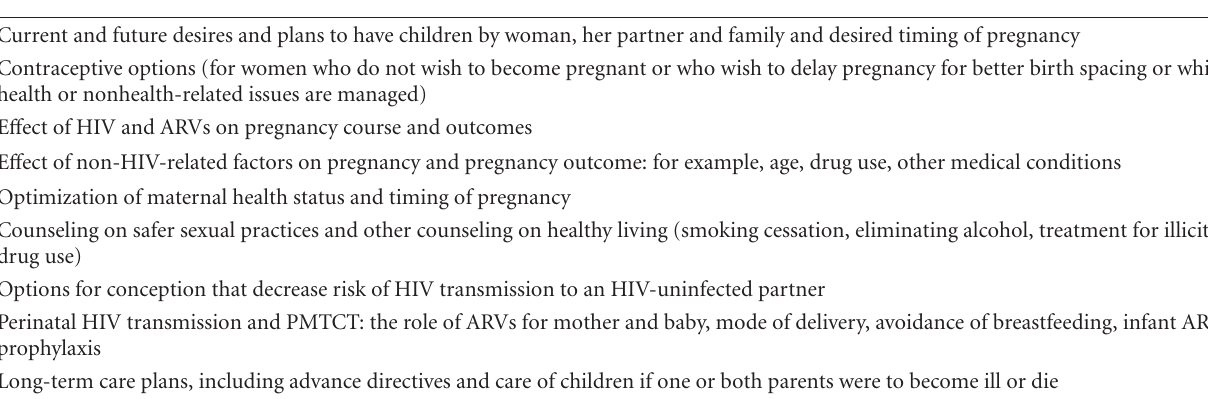
Table 2: Components of preconception counseling for women living with